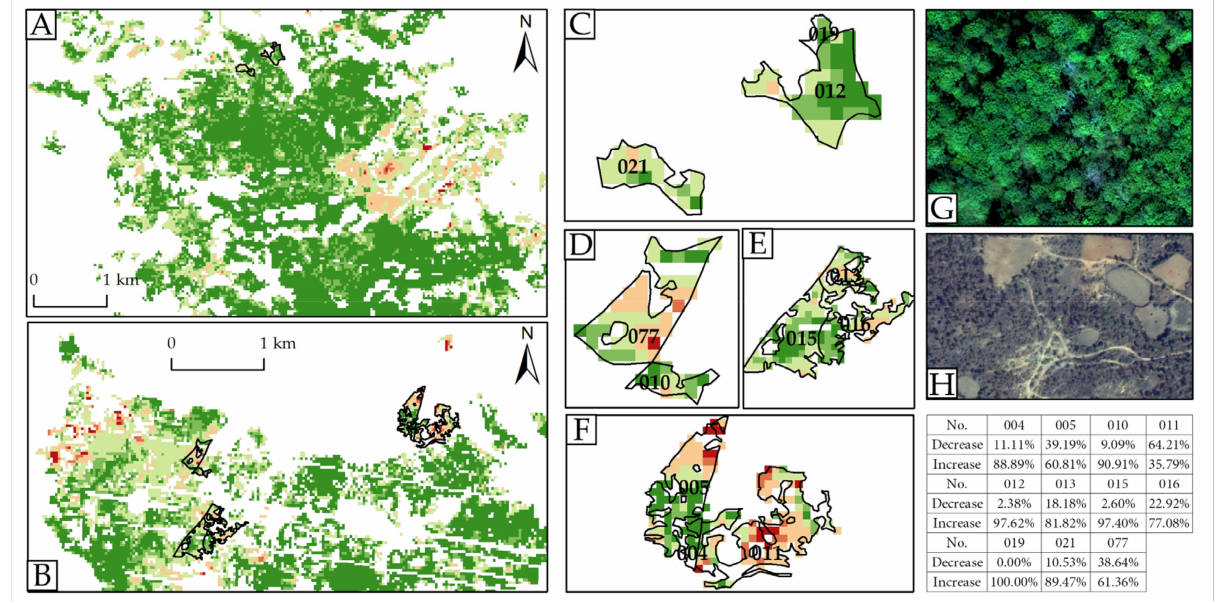
Figure 13. Slope significance test results for NDVI of pine forests in Heilongtan Reservoir and Xijiekou Town (2009–2020). ( A ) Forest area of Heilongtan Reservoir; ( B ) Forest area of Xijiekou Town; ( C ) Ground survey area of Heilongtan Reservoir forest; ( D – F ) Ground survey area of Xijiekou Town forest; ( G ) The image of Heilongtan Reservoir forest; ( H ) The image of Xijiekou Town